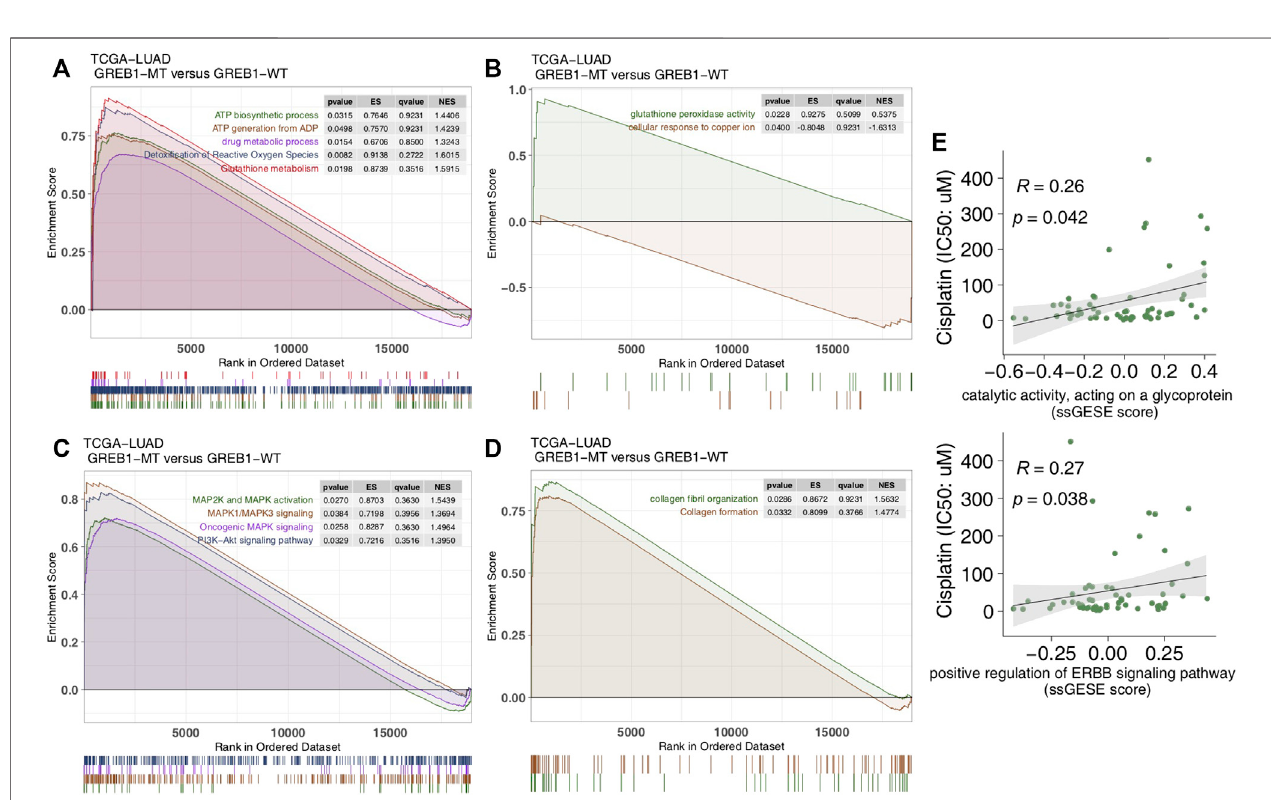
FIGURE 5 | Transcriptome traits in the TCGA-LUAD cohort with or without GREB1 mutations. (A – D) GSEA of hallmark gene sets downloaded from the MSigDB database.Alltranscriptswererankedbylog2(foldchange)betweenGREB1-MT and GREB1-WTLUADpatients.Eachrunwasperformedwith1,000permutations. (E) Correlation between the single-sample GSEA enrichment score and IC50 values of 55 LUAD cell lines in GDSC (Spearman method). GSEA, gene set enrichment analysis; MT, mutant; WT, wild-type; LUAD, lung adenocarcinoma; IC50, half maximal inhibitory concentration; GDSC, Genomics of Drug Sensitivity in Cancer.